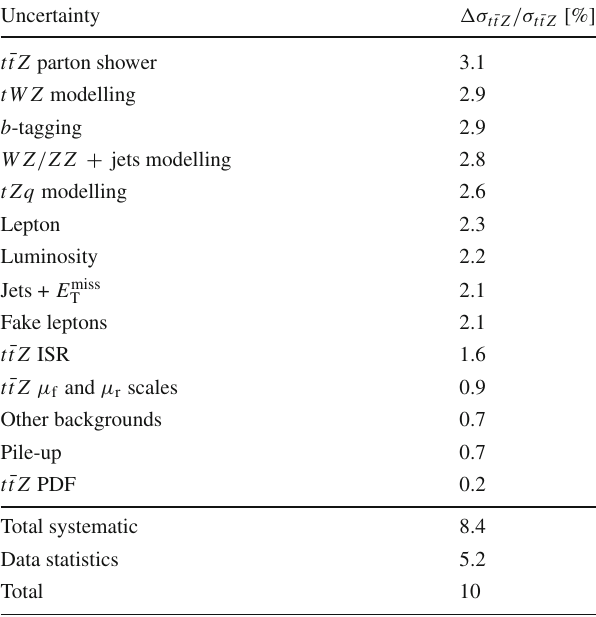
Table 7 List of relative uncertainties of the measured inclusive t ¯ tZ cross section from the combined fit. The uncertainties are symmetrised for presentation and grouped into the categories described in the text. The quadrature sum of the individual uncertainties is not equal to the total uncertainty due to correlations introduced by the